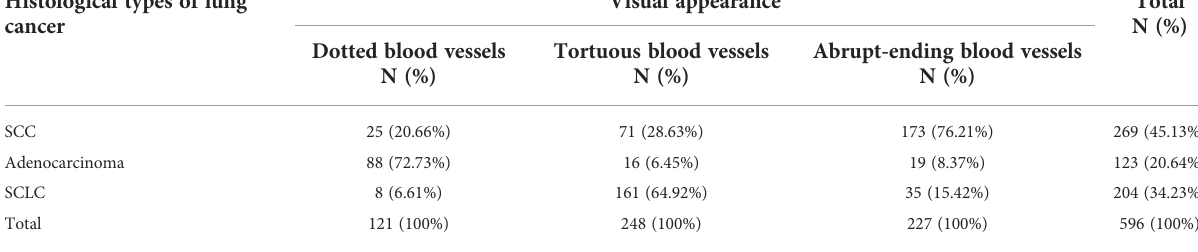
TABLE 4 Relation between histological types of lung cancer and visual appearance of pathological vascularization under narrow band imaging (NBI) video bronchoscopy. Histological types of lung